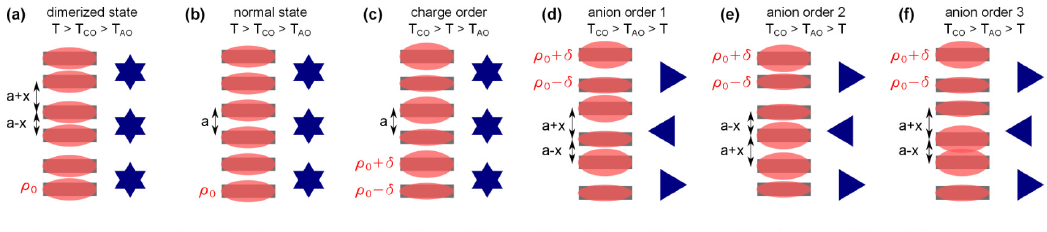
Figure 2. Sketch of the molecular and charge arrangements for different states of (TMTTF) 2 X salts. The organic molecules are depicted as rectangles; the amount of charge ρ 0 , ρ 0 ± δ is illustrated by red ellipses of different size. The anions are shown as blue hexagons or triangles, depending on the centrosymmetry. ( a ) The TMTTF stacks are dimerized at room temperature, a ± x . The degree of dimerization decreases upon cooling, thus equalizing the TMTTF sites towards the uniform state in ( b ). Panel ( c ) illustrates how charge disproportionation develops as the charge-ordered state is entered with a 1010 charge pattern along the stacking direction. A priori, three different charge configurations are possible in the anion-ordered phase: ( d ) one with a 1010 pattern and ( e,f ) two with a 1100